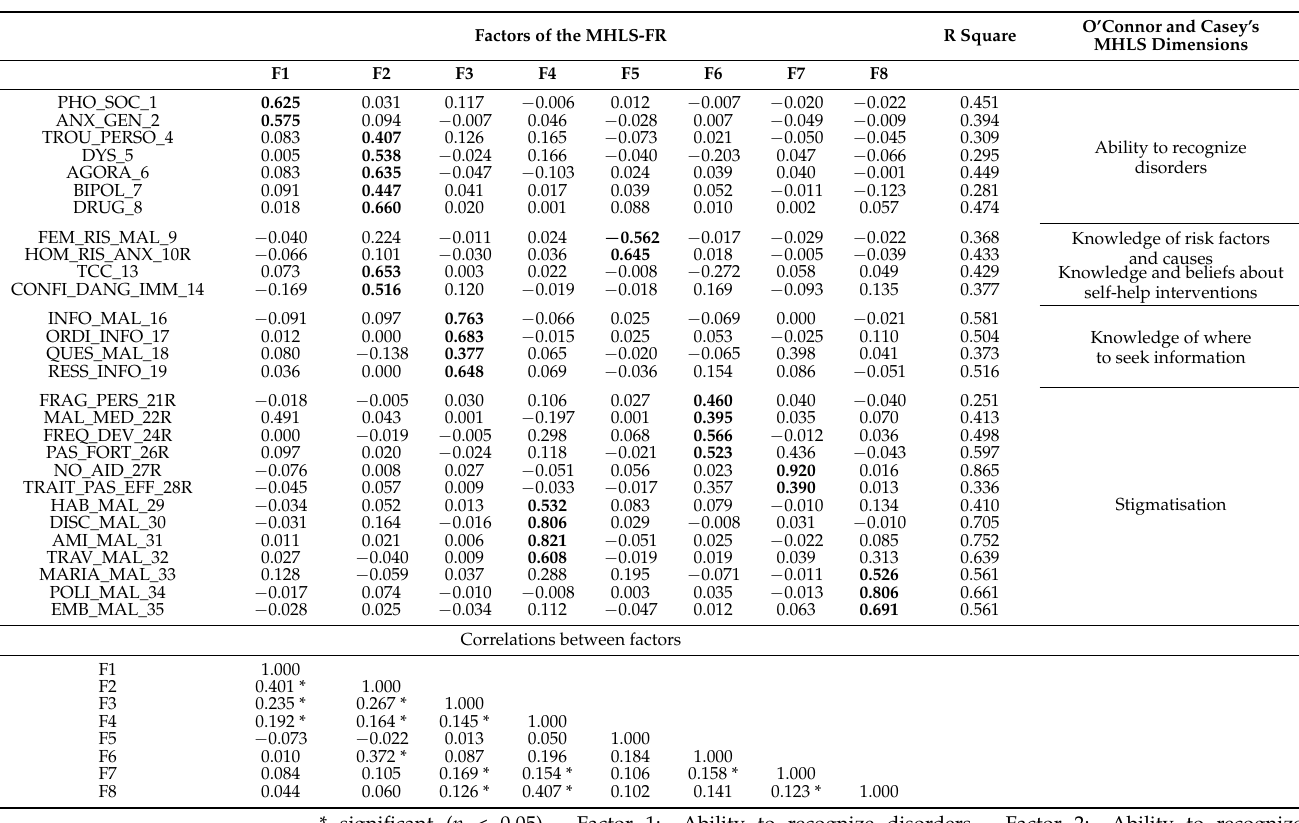
Table 2. MHLS-FR dimensions based on model 5. Factors of the